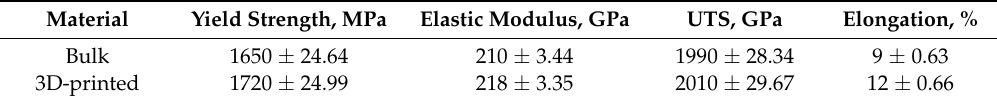
Table 2. Mechanical properties of the bulk and 3D-printed AISI H13 tool